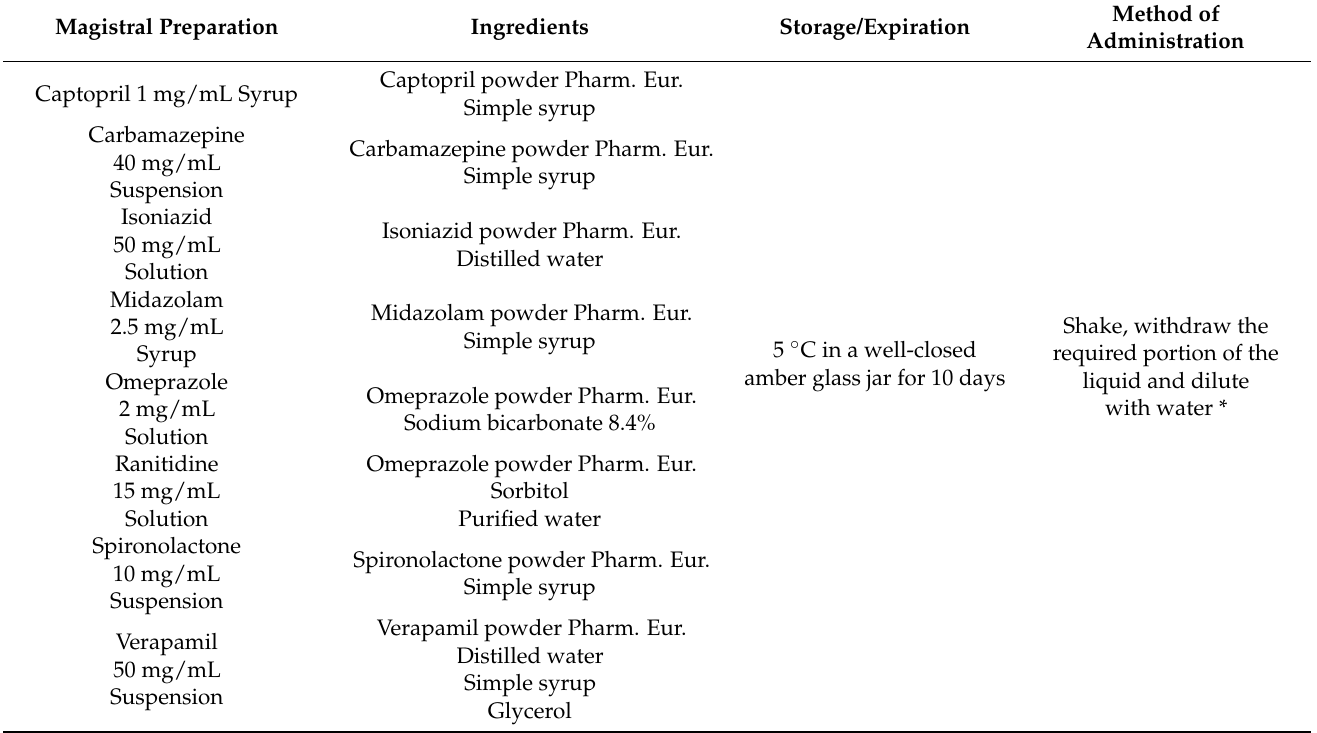
Table 4. List of magistral preparations routinely compounded in the hospital